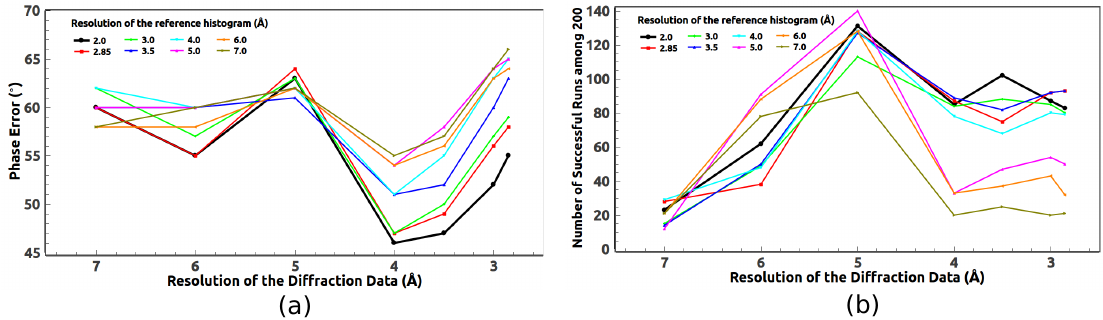
Figure 12. ( a ) The phase error and ( b ) the number of successful runs of 2JLN when the reference histograms in Figure 11 are tested on the observed data at various resolutions.